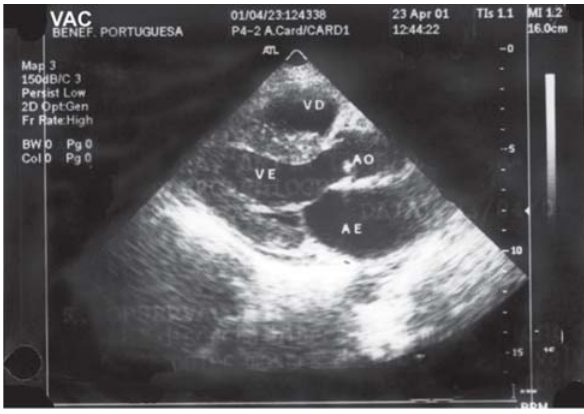
Fig. 1 – Ecocardiograma evidenciou doença de depósito (observe o septo